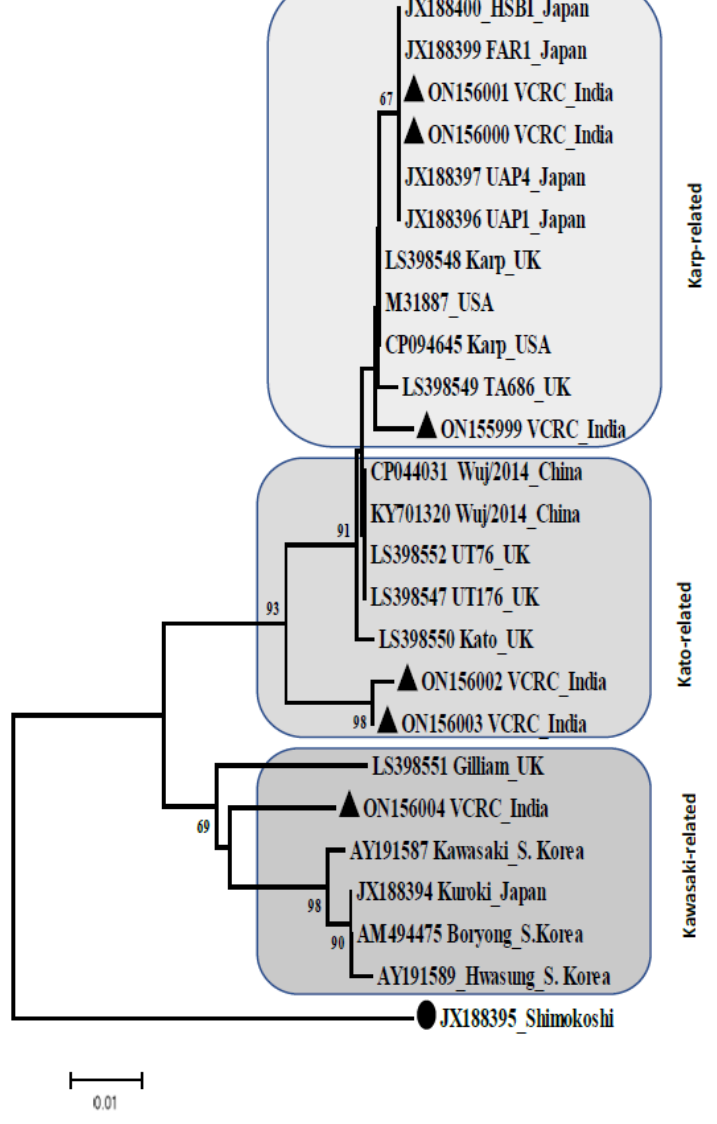
Figure 2. Phylogenetic analysis of O. tsutsugamushi using the GroEL gene sequences (365 bp) from Karp, Kato, and Kawasaki-related serotypes . The neighbor joining (NJ) tree was generated using closely related sequences with 500 bootstrap replicates. ▲ : Sequences from this study; ● : out-group.